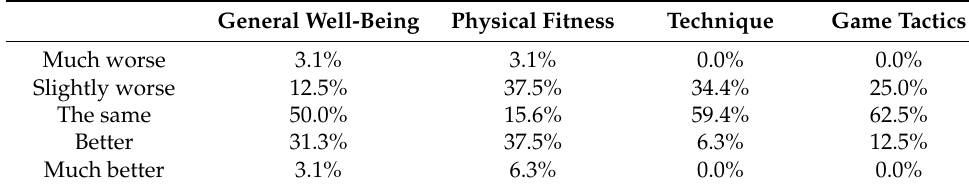
Table 3. The athletes’ observed changes during the COVID-19 lockdown.